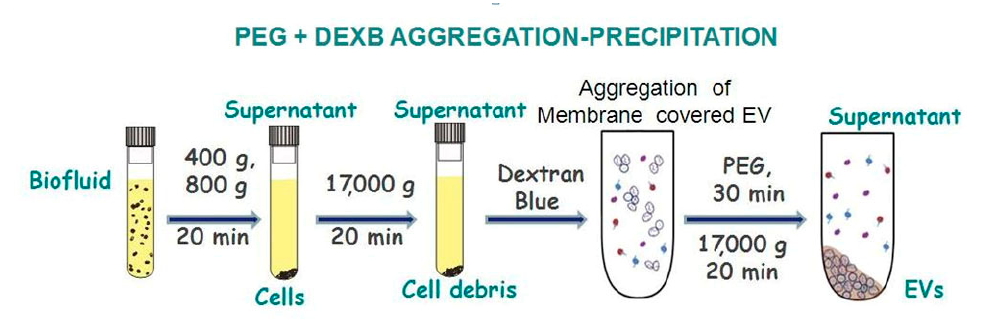
Figure 7. The scheme of the PEG- and DEXB-based precipitation of extracellular vesicles.